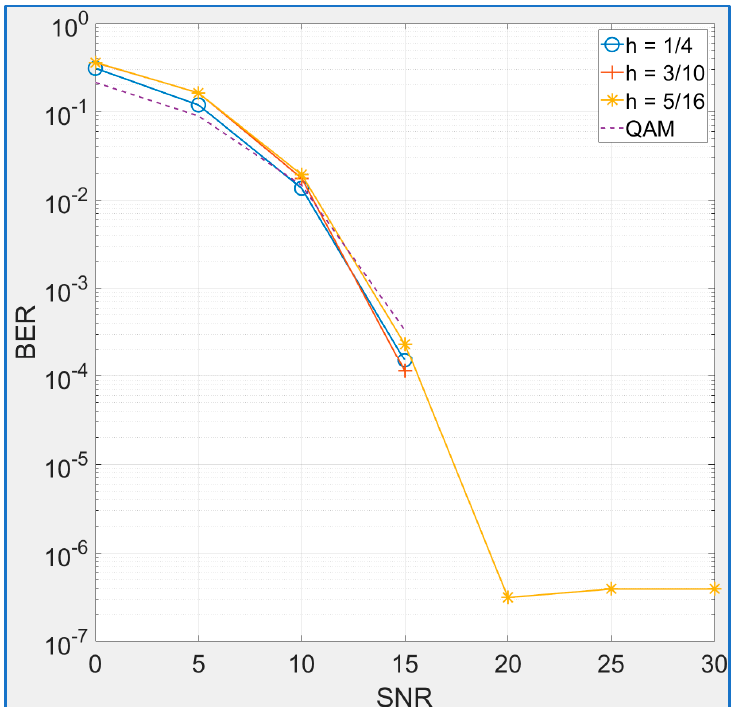
Figure 15 . BER performance of CPM-GFDM v.s QAM-GFDM with 𝐽 = 4 for zero forcing receiver Figure 15. BER performance of CPM-GFDM v.s QAM-GFDM with J = 4 for zero forcing receiver over frequency-selective over frequency-selective channels.